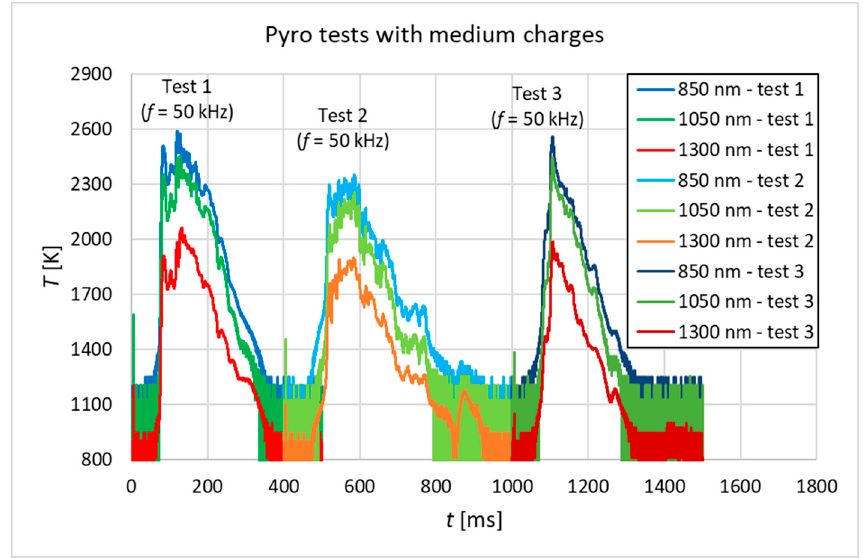
Figure 10. Time trend of temperatures for pyrotechnic tests with medium charges—temporal offset introduced for clarity.